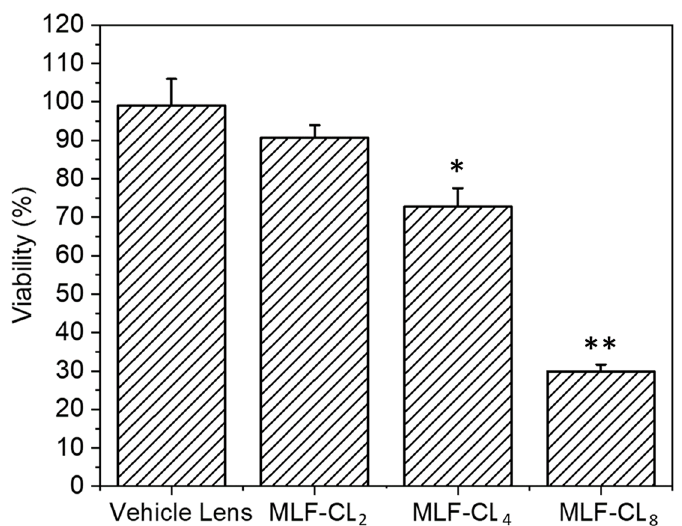
Figure 7. Cell viability of L929s with eluted media from miltefosine-eluting contact lenses (MLF-CLs). Results are expressed as percent viability of untreated L929s. Cell viability for MLF-CLs compared to vehicle lenses. * p = 0.017, ** p < 0.001 by Kruskal–Wallis Test with Bonferroni correction. n = 4.